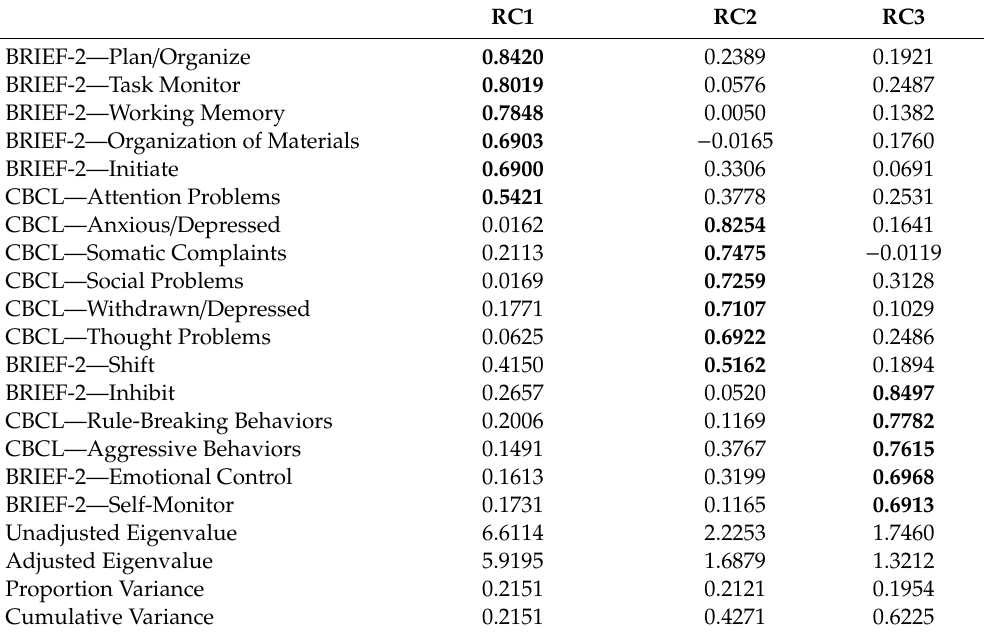
Table 4. Principal component analysis.